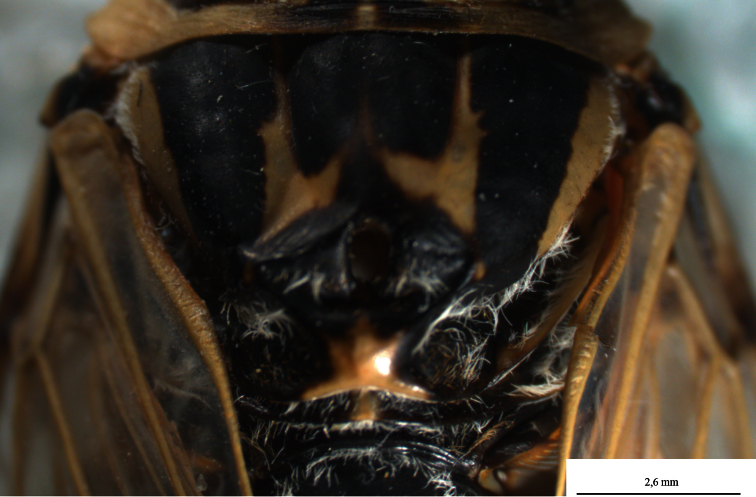
Cicadatra platyptera, mesonotum (scale= 2 mm).